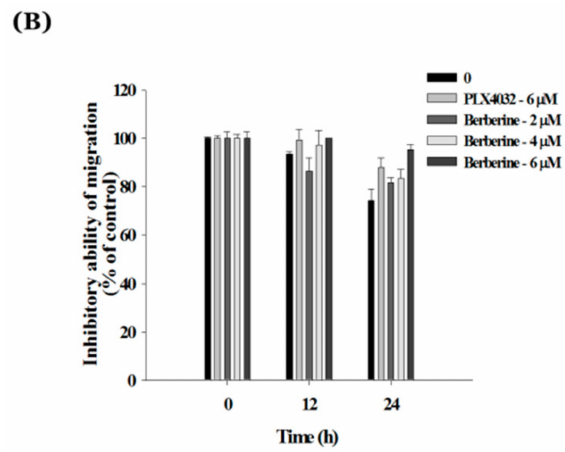
Figure 6. Berberine affected the in vitro wound closure of A375.S2/PLX resistant cells. The cells (2 × 10 5 cells/well) were kept in 12-well plates for 24 h, were scratched, and were incubated with PLX4032 or berberine (0, 2, 4, and 6 µ M) for 48 h. The relative wound closures were photographed using phase contrast microscopy ( A ) and the percentage of inhibitory abilities was calculated ( B ) as described in the Materials and Methods. * p < 0.05, significant difference between berberine-treated groups and the control, as analyzed by one-way ANOVA analysis of